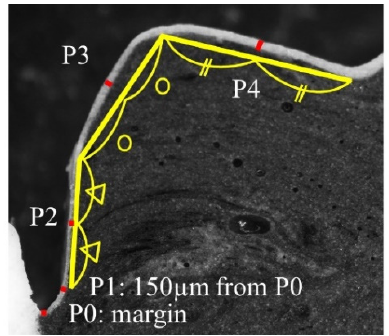
Figure 2. Reference points for evaluation of internal adaptation of the crown.